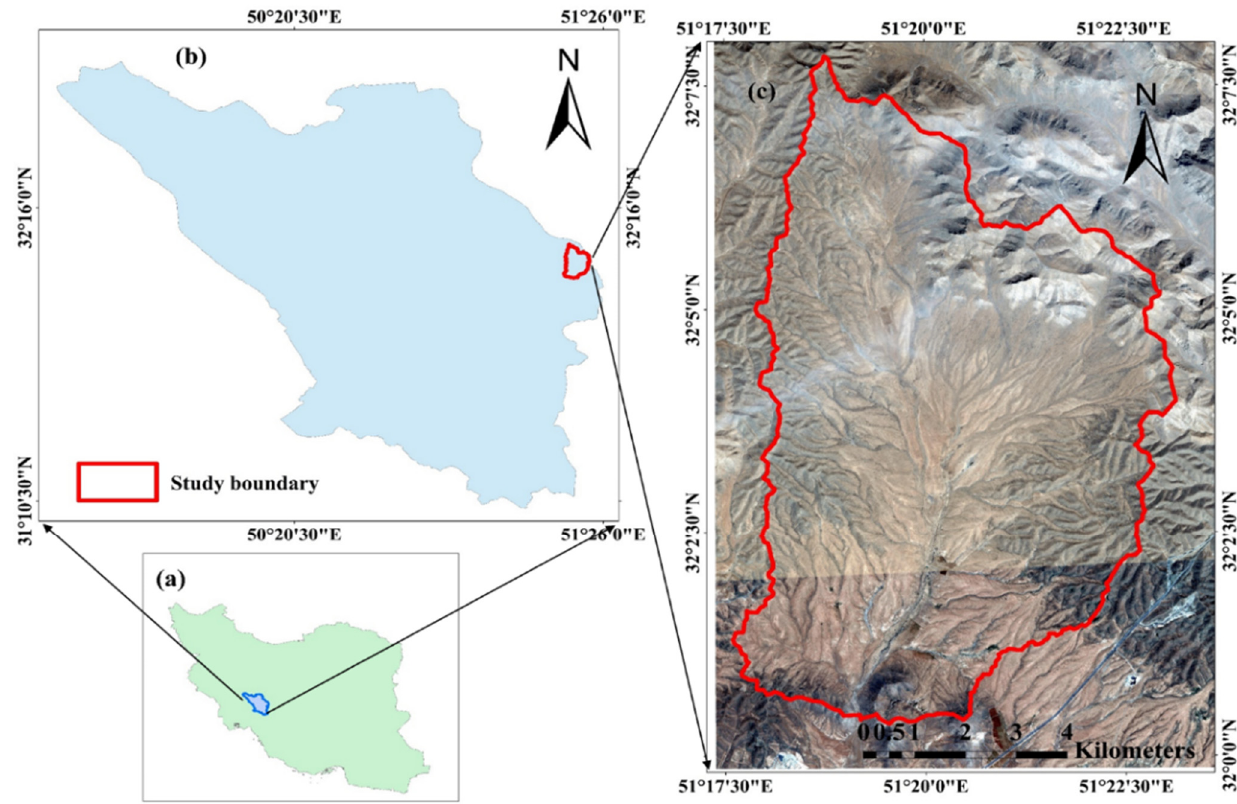
Figure 1. The location of the study area: ( a )—Iran border; ( b )—Chaharmahal-Va Bakhtiari border; and ( c )—Study area border (Marjan).